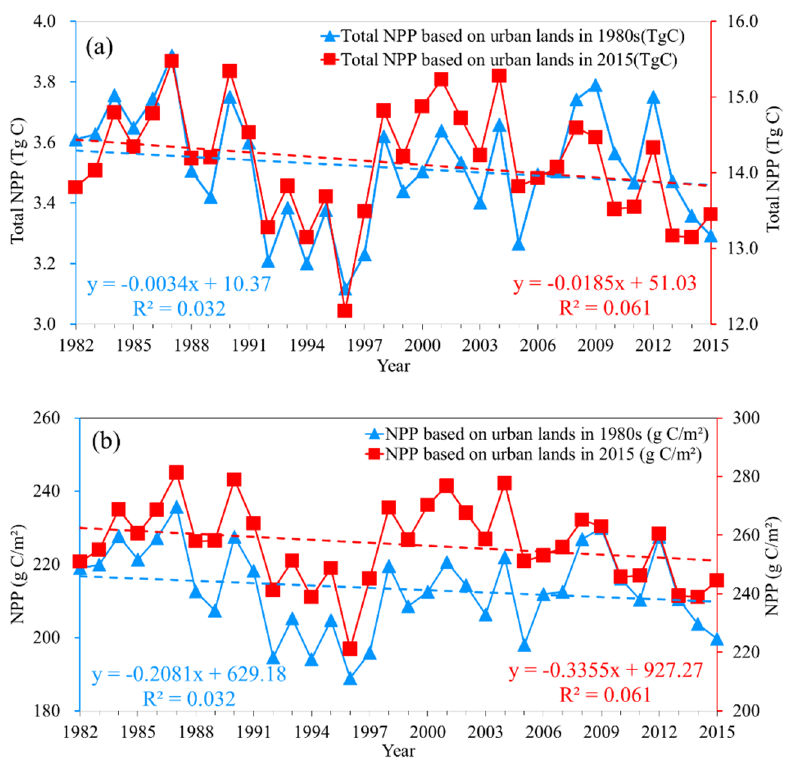
Figure 5. ( a ) Total NPP trend and ( b ) average NPP trend based on urban lands in the 1980s (blue lines, left-hand vertical axis) and 2015 (red lines, right-hand vertical axis).